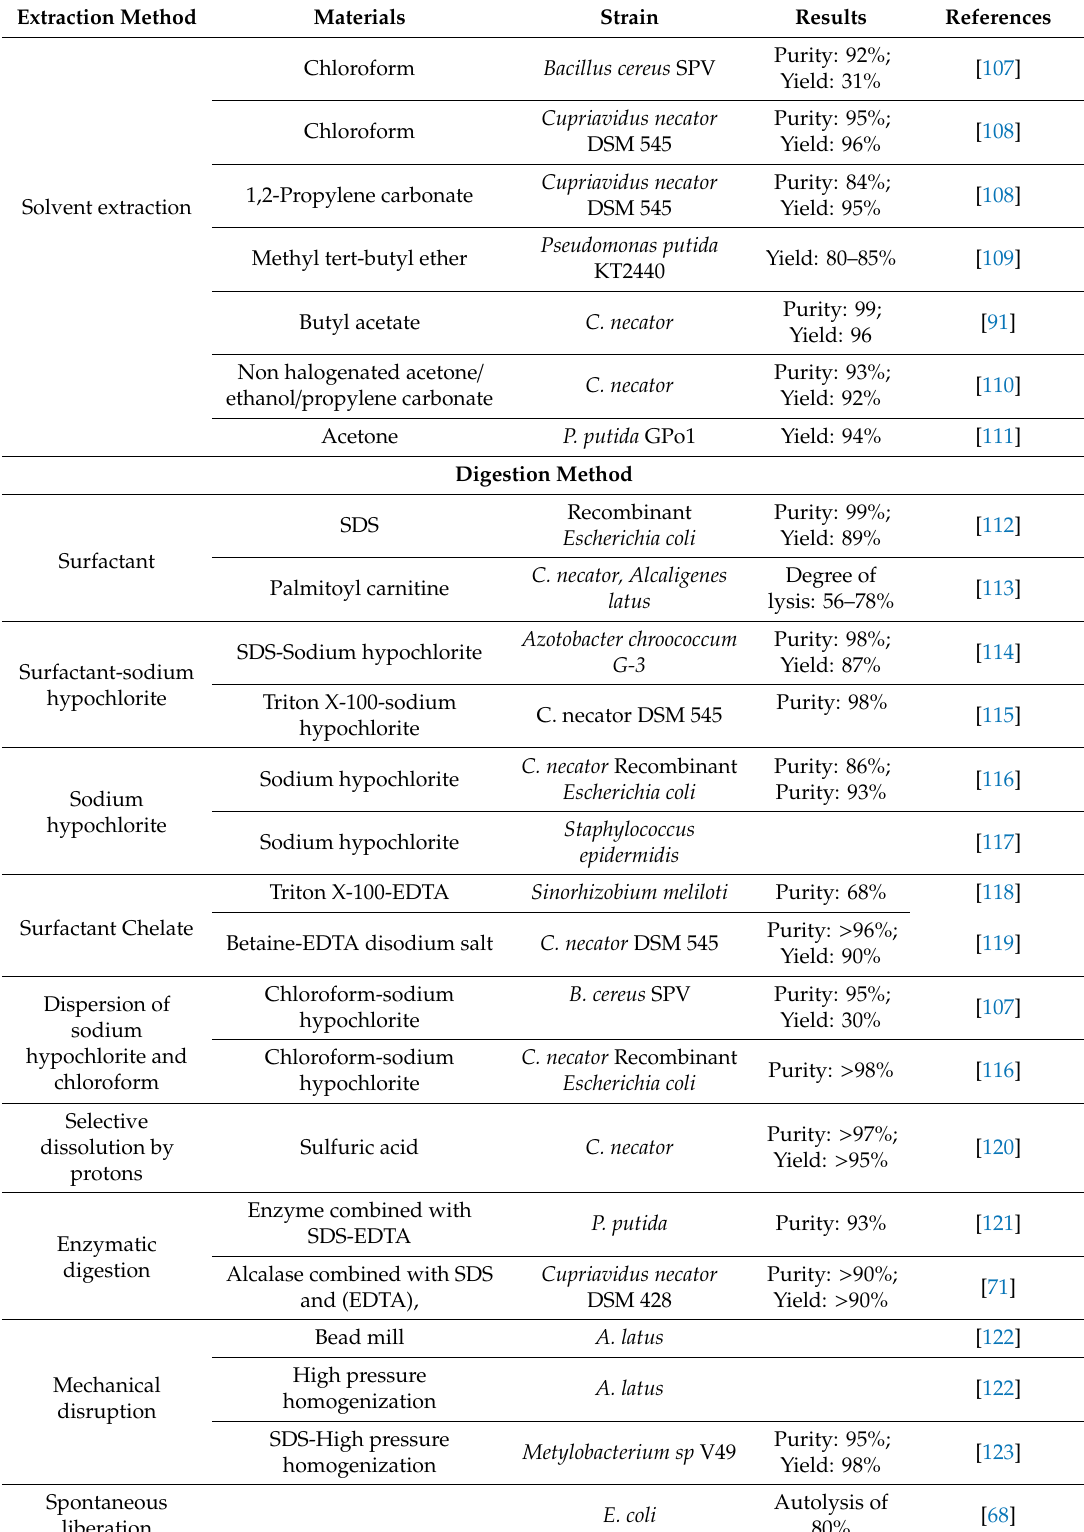
Table 7. PHB recovery methods reported in